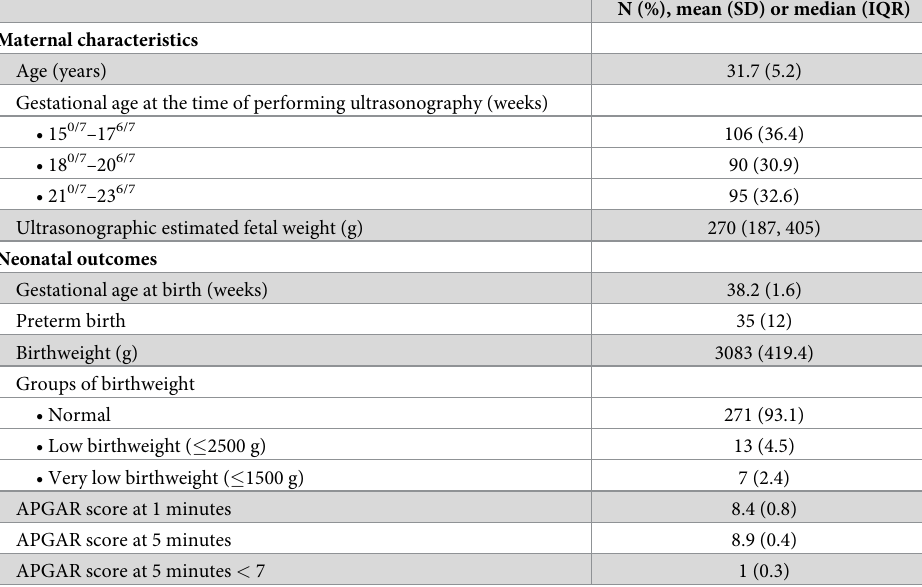
Table 1. Demographic data and neonatal outcomes (N = 291).